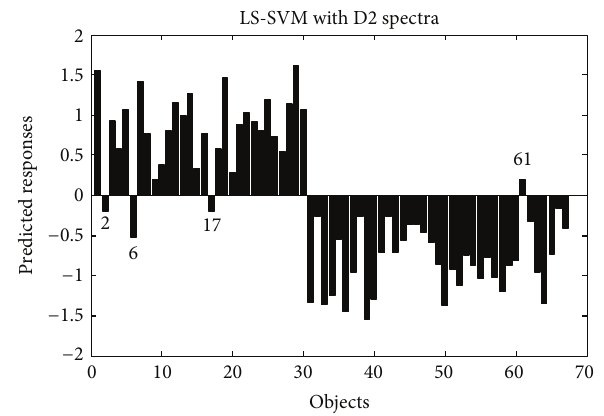
Figure 5: Prediction results of LS-SVM with D2 spectra. Objects 1–30 are PDO WLS and 31–67 are non-PDO